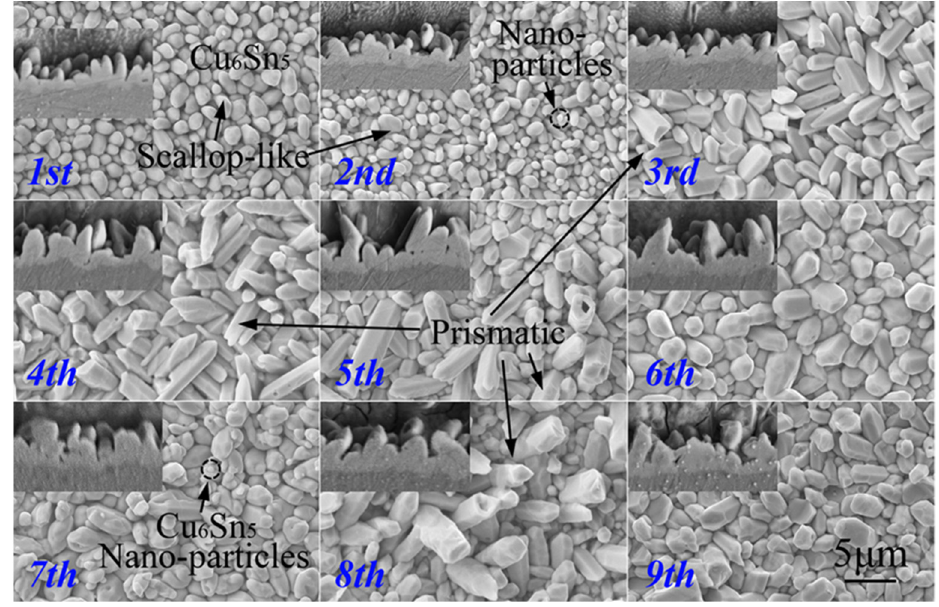
Figure 2. Top-view and cross-section morphologies of Cu 6 Sn 5 during the nine-time reflow process. Since the diffusion rate of Cu is faster than Sn, the growth behavior of Cu 6 Sn 5 is mainly controlled by Cu diffusion [22,23,30]. Figure 3 is the Cu mass fraction in solder obtained by experiment (a) and simulation (b) (for further details, see part I in Supplementary Material). For each sample, three points were selected for measurement to obtain the average value of the Cu mass fraction. Figure 3c presents the plots of the measured and calculated Cu mass fractions. Clearly, the Cu mass fraction increased as the number of reflow cycles increased. In the process of multiple reflow, Cu atoms continuously dif- fused from the substrate into the liquid solder, resulting in the increase in the Cu concen- tration in the solder joint.